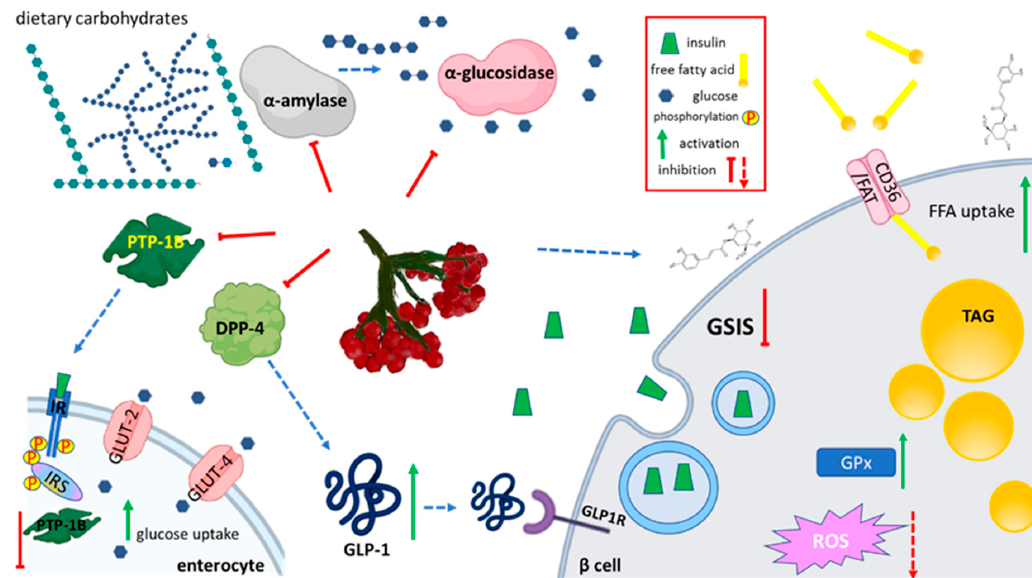
Figure 2. Proposed molecular mechanisms of anti-diabetic actions of Viburnum opulus ; see the main text for more details. CD36/FAT—fatty acid translocase; DPP-4—dipeptidyl peptidase-4; FFA—free